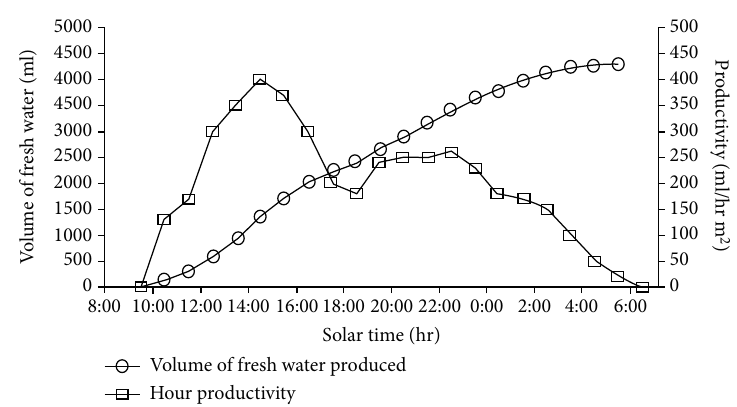
Figure 30: Productivity and freshwater volume vs. solar time [72].